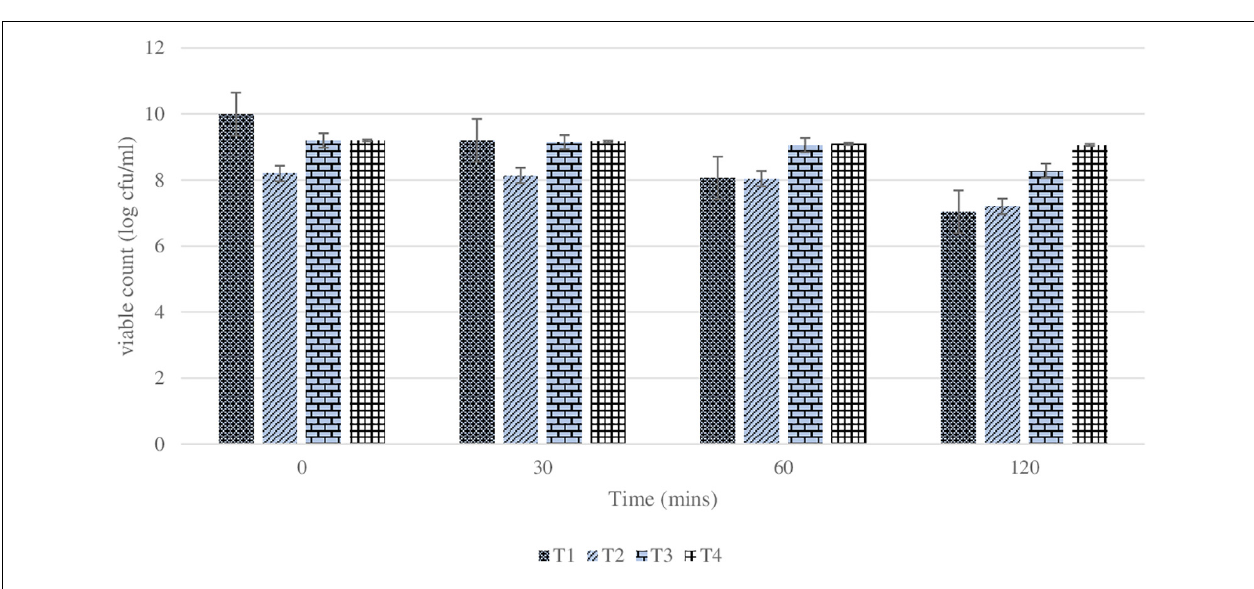
FIGURE 3 | Changes in viability (cell count) of plain or coated L. rhamnosus cells after exposure to simulated gastric fluids for 30, 60, and 120 min. Tl: plain L. rhamnosus, T2: coated cells with BSP/Glucomannan, T3: coated cells with ESP/Alginate and T4:coated cells with